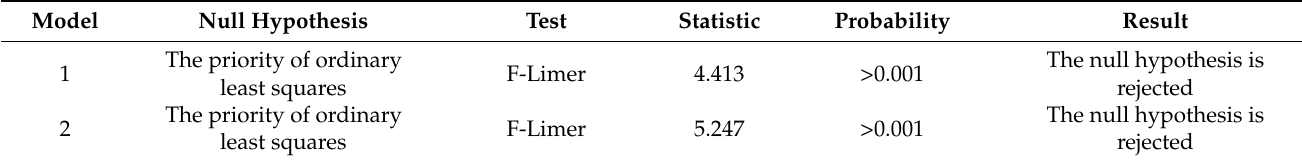
Table 2. The results of the F-Limer test performed for selecting ordinary least squares or panel data.